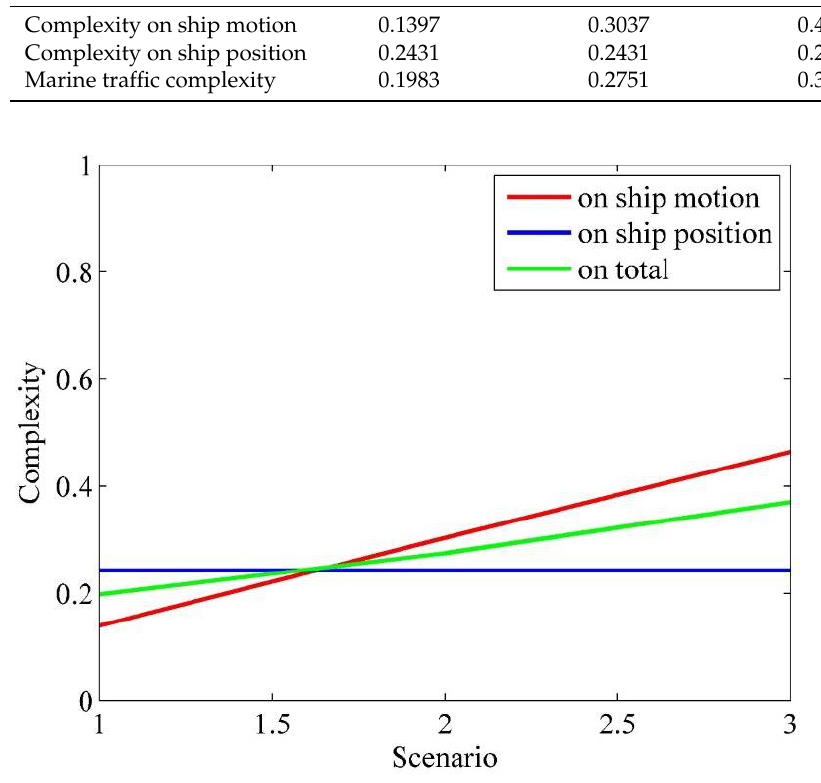
Figure 7. The results of the first simulated case study.